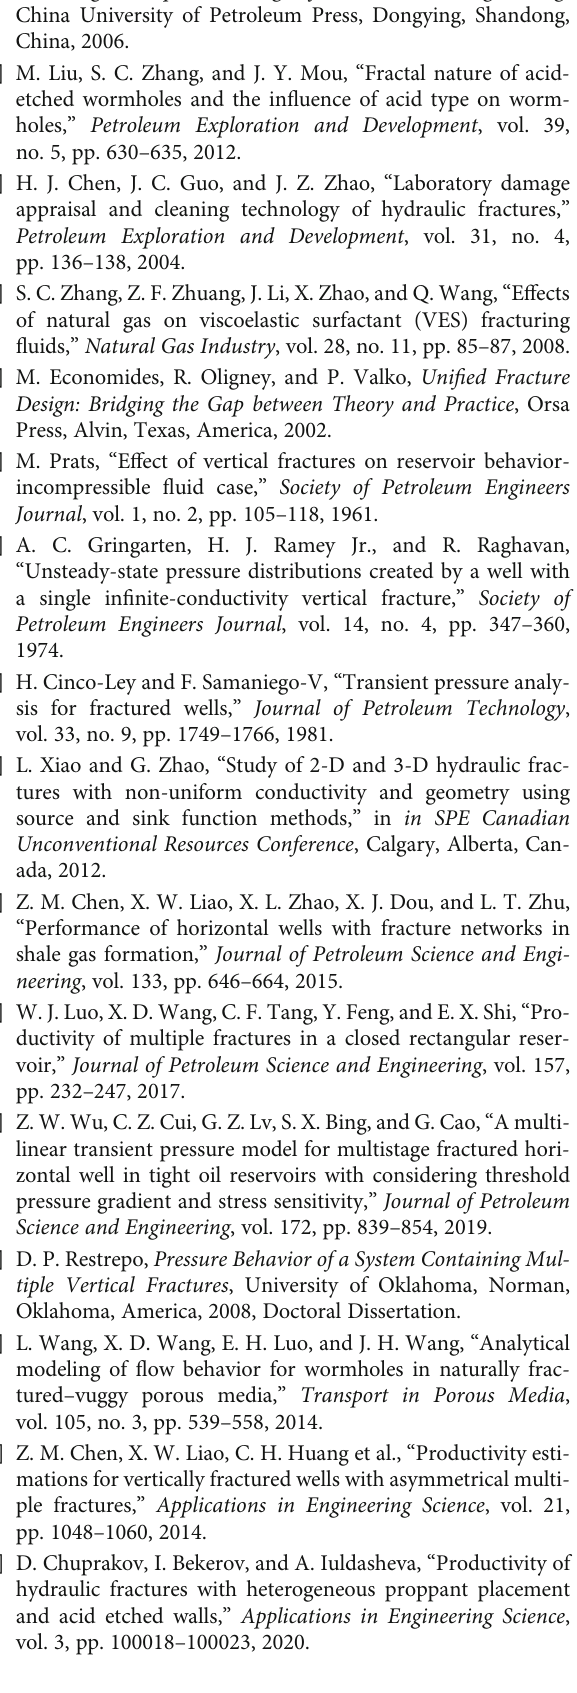
Inner zone 2 f : Natural fracture system in outer